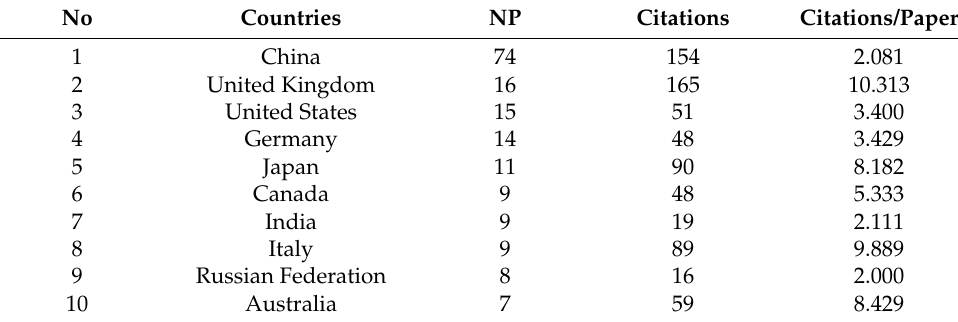
Table 2. The most productive countries (line